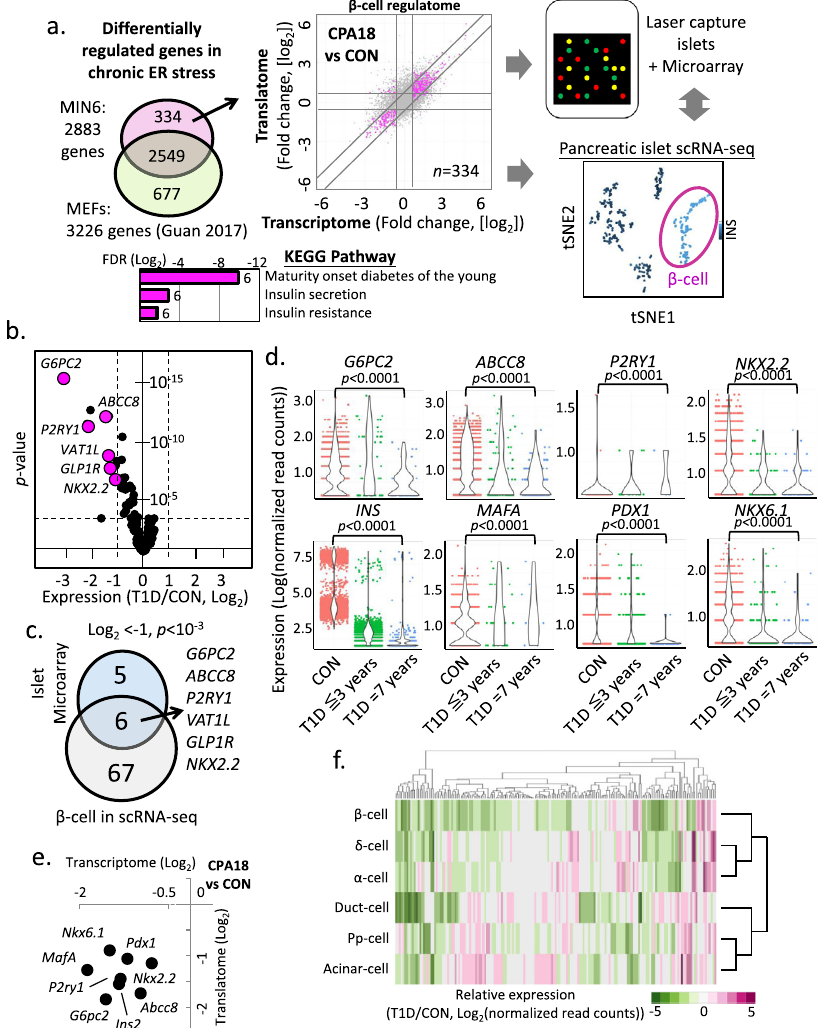
Fig. 6 | Altered expression of the β -cell ER stress-induced gene set (regulome) inT1DisletsrevealsbiomarkersofT1Dprogression.a Schematicrepresentation of the β -cell ER stress gene set (334 genes) in MIN6 cells and determination of its expression in T1D islets or scRNA-seq datasets. Scatterplot indicates in color the expressionpatternsofthe334genesetduringchronicERstressinMIN6cells.The KEEGpathwayofthe334genesetisshownbelow a . b The334genesetexpression pro fi leinT1Disletmicroarraydatasets,shownbyavolcanoplot. p -valuerepresents the statistical test between CON and T1D by two-sided Wilcoxon – Mann – Whitney test. c Venn-diagram showing the common repressed genes of the 334 gene set in